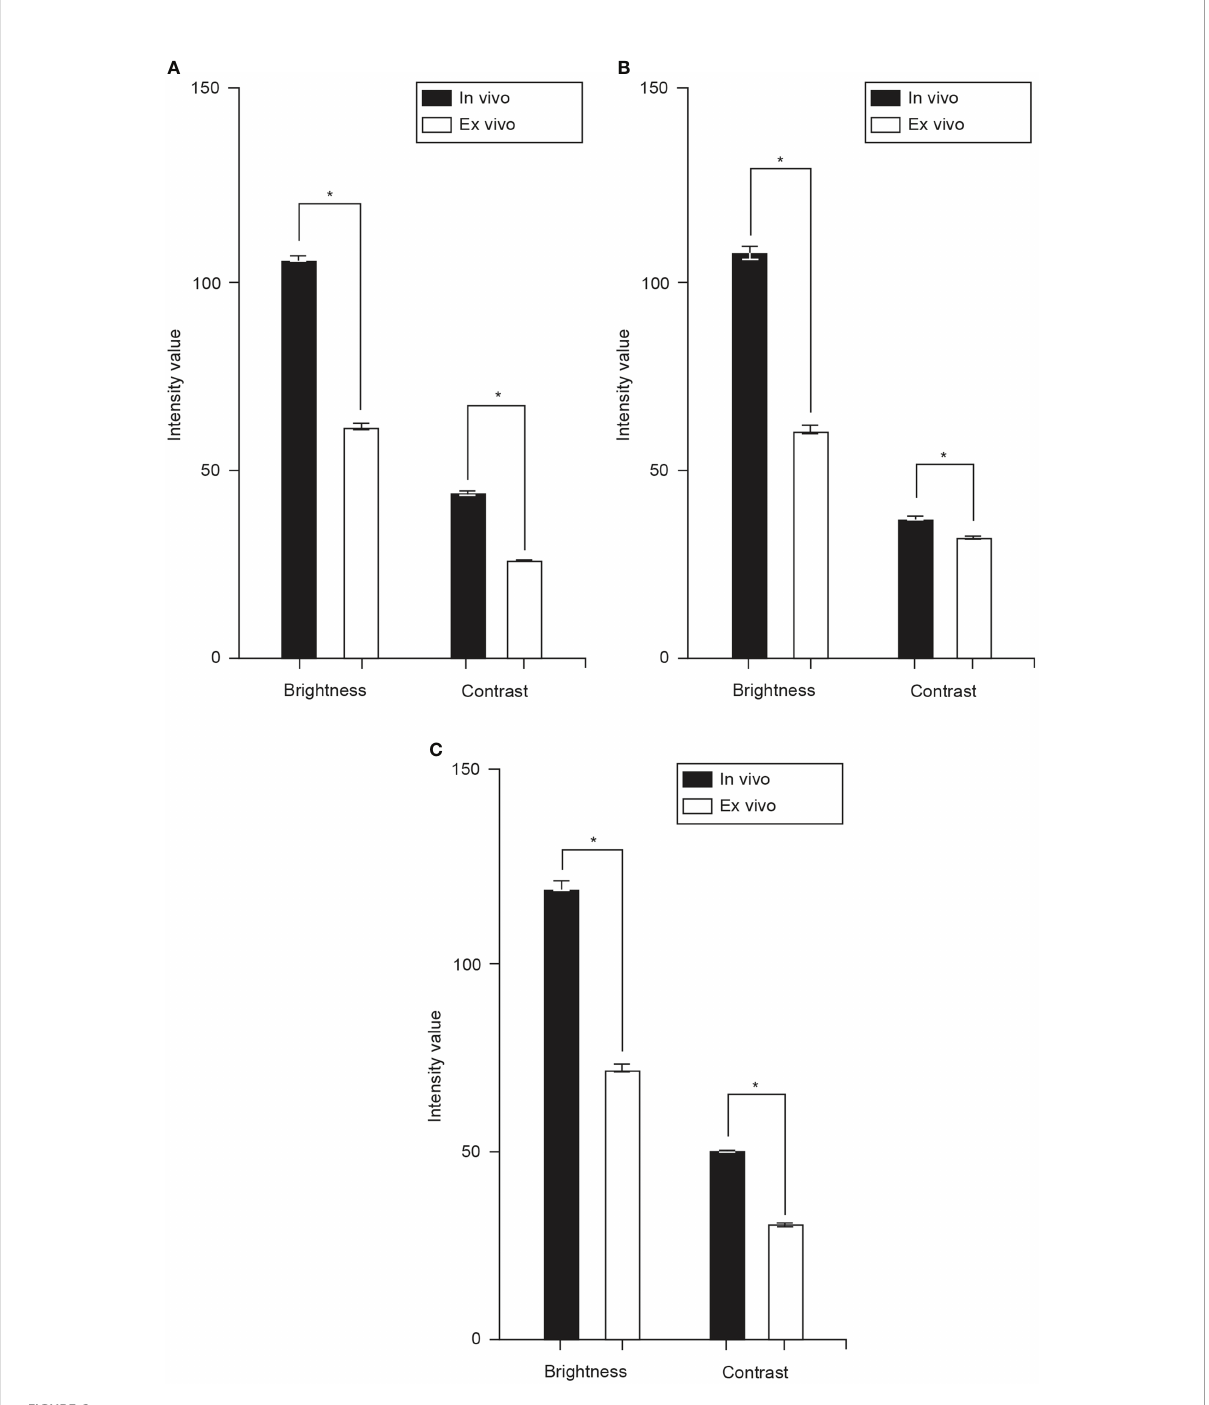
FIGURE 6 Bar charts showing mean brightness and contrast of images from glioma (A) , meningioma (B) , and intracranial metastatic tumor (C) cases from both studies. The mean brightness and contrast of the in vivo images from glioma (brightness: 105.2 [25.8] vs. 60.6 [8.1], p < 0.001; contrast: 43.2 [24.9] vs. 26.5 [6.9], p < 0.001), meningioma (brightness: 106.3 [26.0] vs. 60.0 [18.8], p < 0.001; contrast: 36.7 [8.0] vs. 31.7 [8.9], p < 0.001), and intracranial metastatic tumor (brightness: 118.2 [26.5] vs. 70.6 [25.1], p < 0.001; contrast: 49.6 [4.9] vs. 30.1 [6.8], p < 0.001, Figure 6C values are signi fi cantly higher than those of the ex vivo images. Values are reported in optical density units de fi ned by Fiji software. Asterisk indicates p < 0.001. Used with permission from Barrow Neurological Institute, Phoenix,